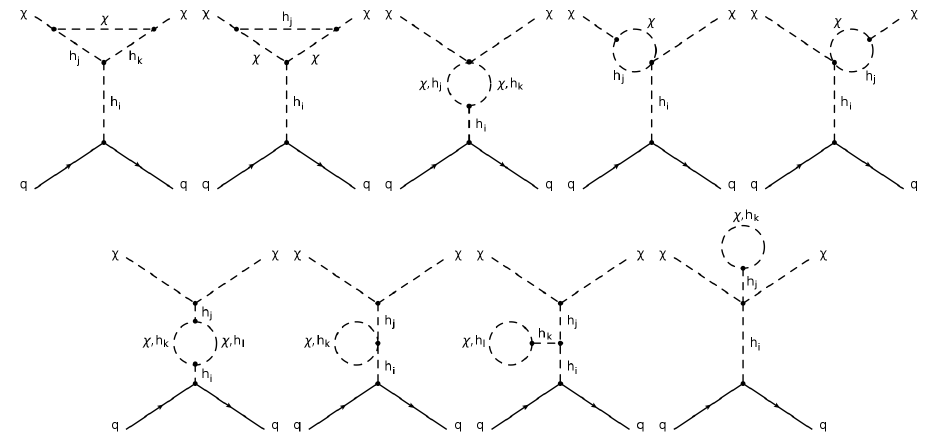
Figure 5 . One-loop topologies that contribute to the DM-nucleon scattering cross section in our approximation with q ∈ { u, d, c, s, b, t } and i, j, k, l ∈ { 1 , 2 , 3 }